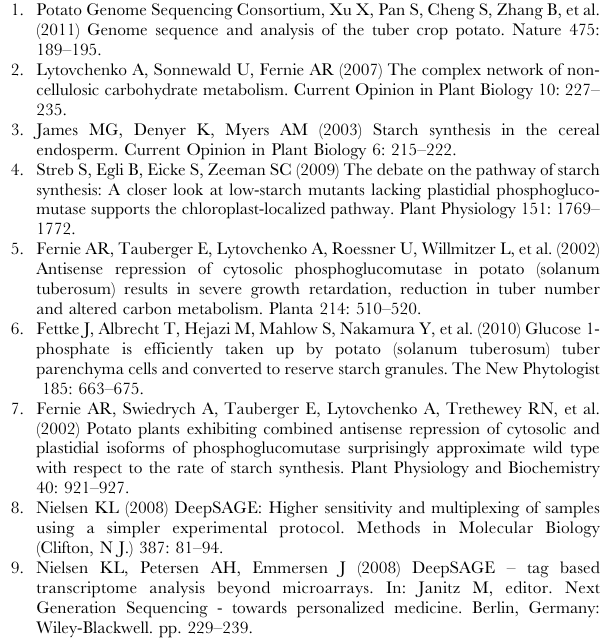
Table outlines the essential genes in starch metabolism. Primary annotation names marked with asterisk indicate that different tags matching multiple enzyme isoforms were taken together and their counts were summed. Tag counts represent libraries of combined biological